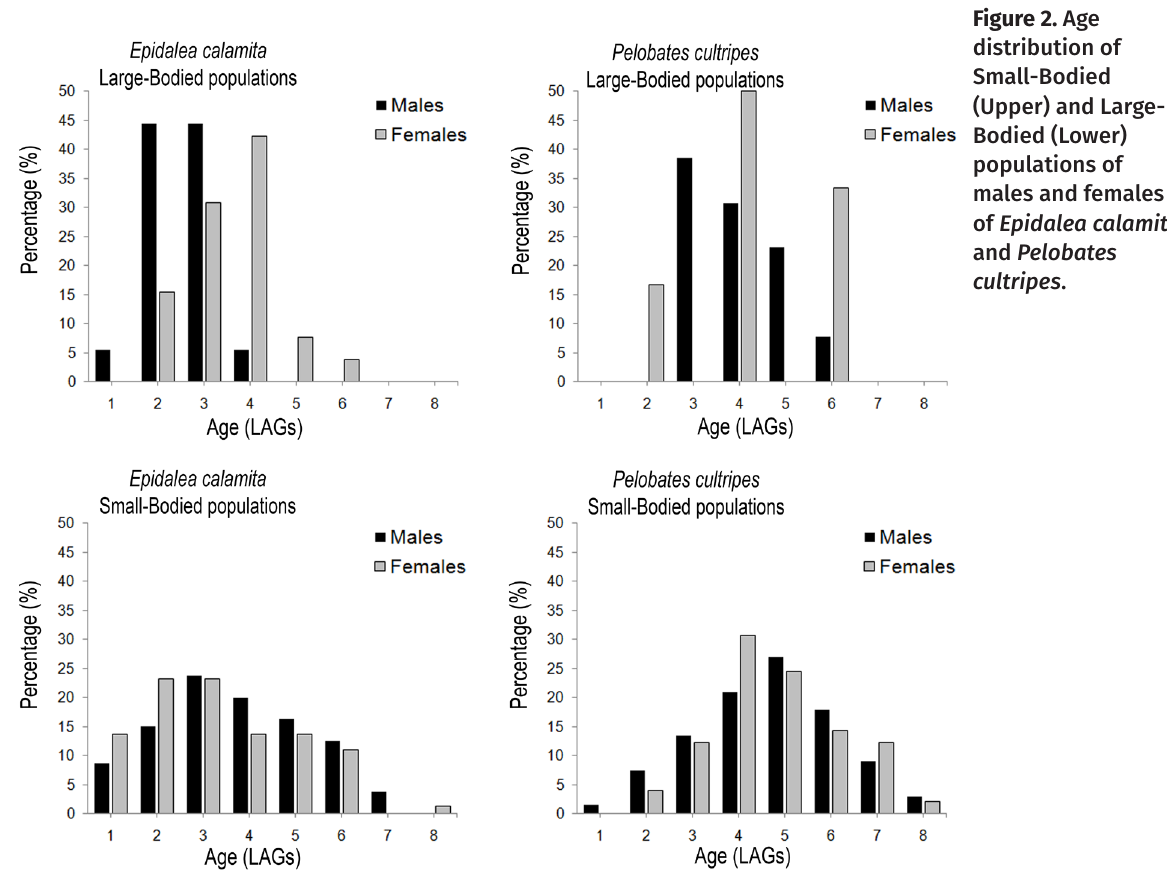
Figure 2. Age distribution of Small-Bodied (Upper) and Large- Bodied (Lower) populations of males and females of Epidalea calamita and Pelobates cultripes